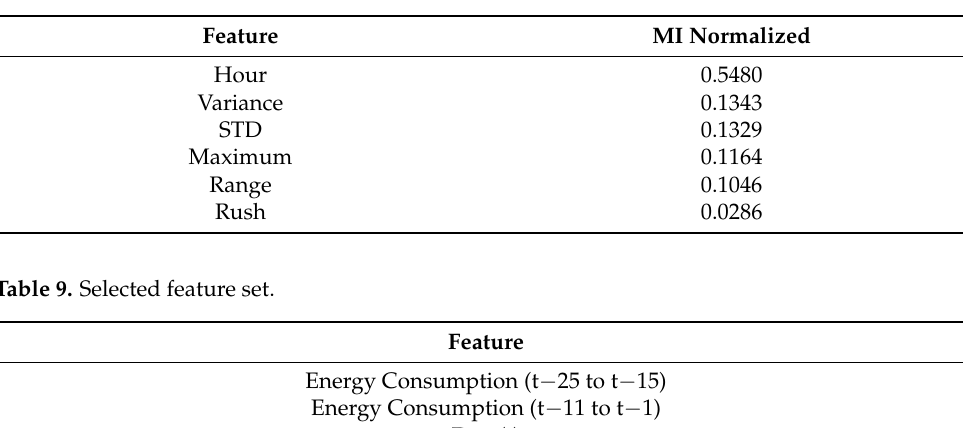
Figure 6. Normalized mutual information to each pair of features. Table 8. Normalized mutual information of each feature regarding energy consumption.